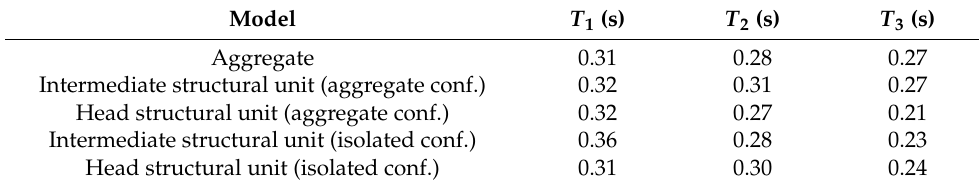
Table 1. Main vibration periods associated with the examined structural configurations. Model T 1 (s) T 2 (s) T 3 (s) Aggregate 0.31 0.28 0.27 Intermediate structural unit (aggregate conf.) 0.32 0.31 0.27 Head structural unit (aggregate conf.) 0.32 0.27 0.21 Intermediate structural unit (isolated conf.) 0.36 0.28 Head structural unit (isolated